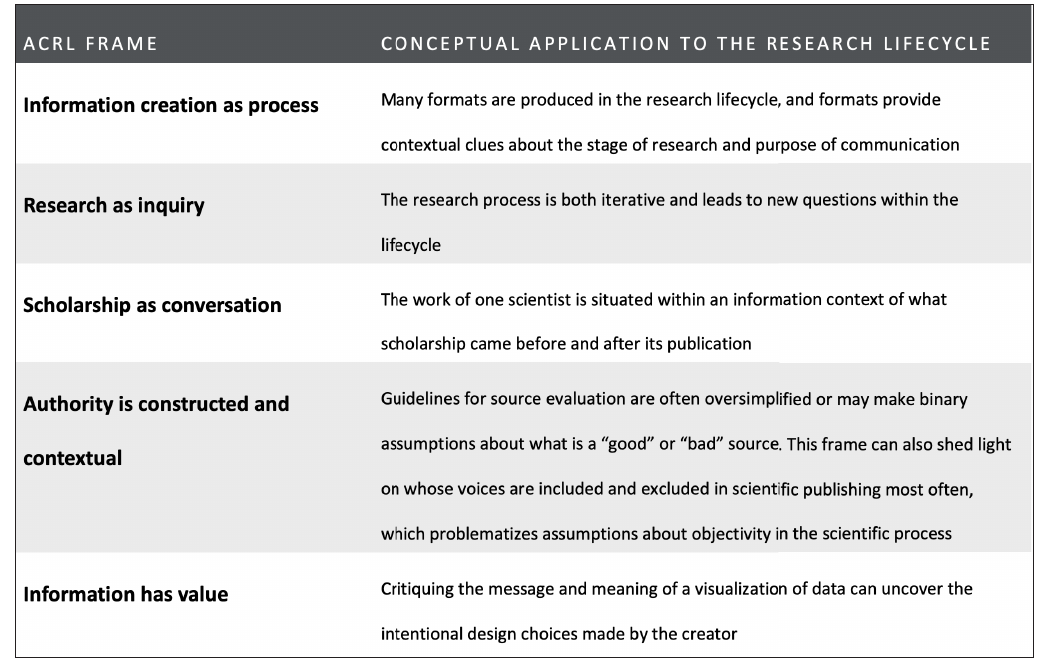
Figure 1 : ACRL frames and the research